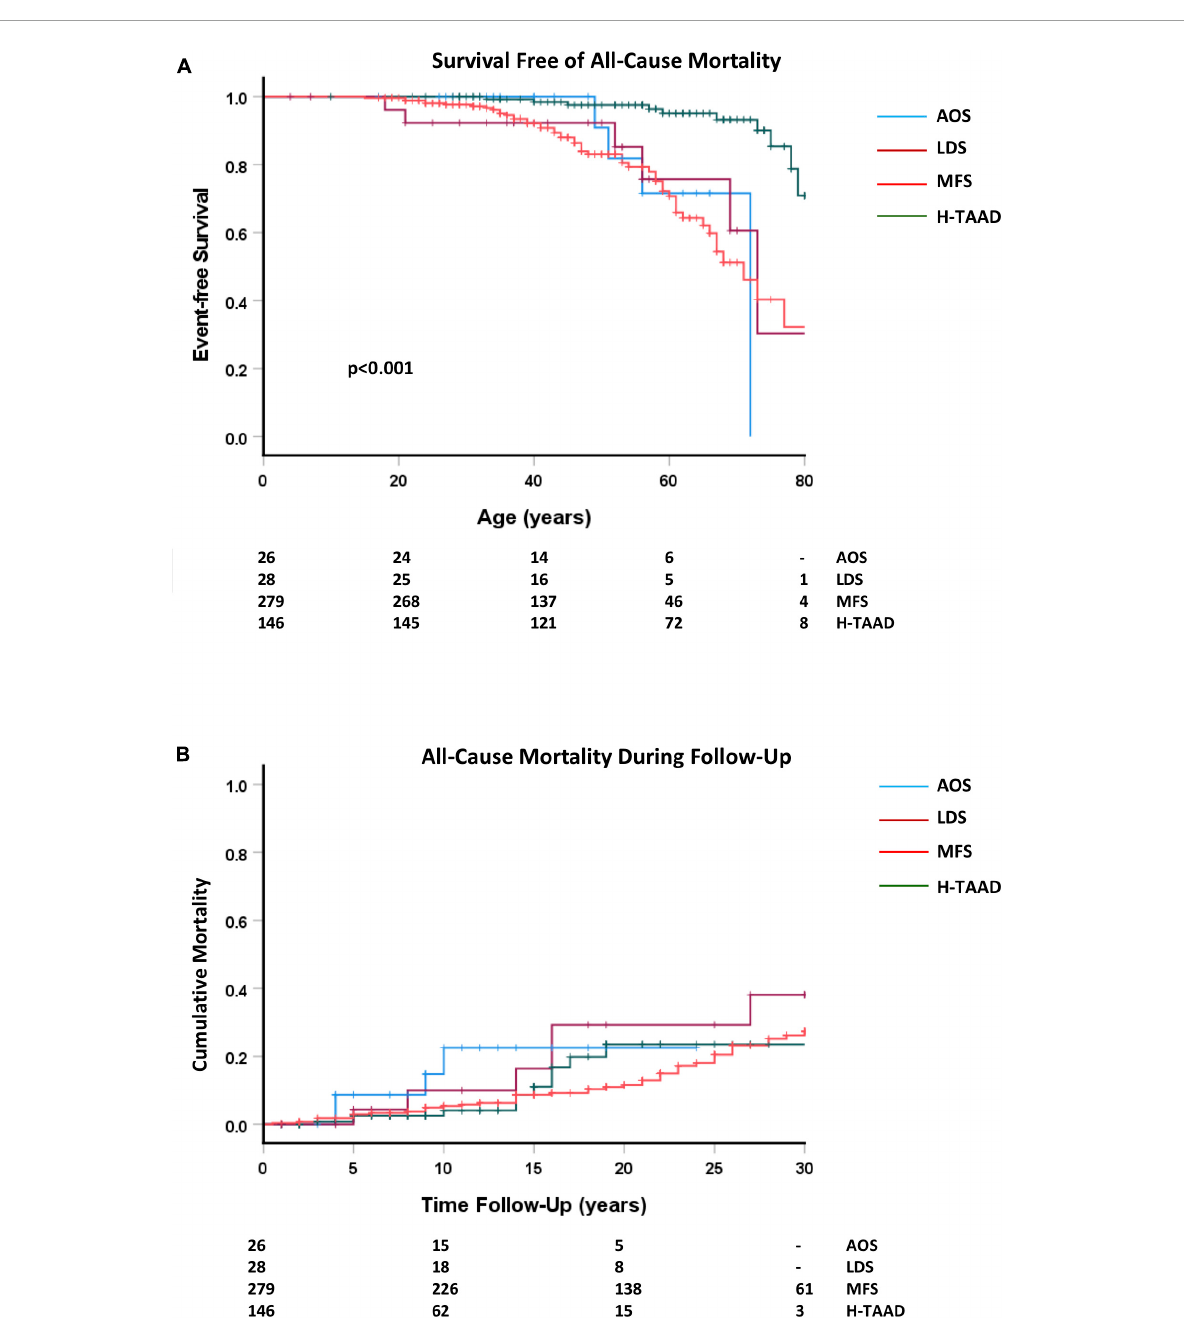
angiotensin receptor blockers and for H-TAAD patients taking beta-blockers.